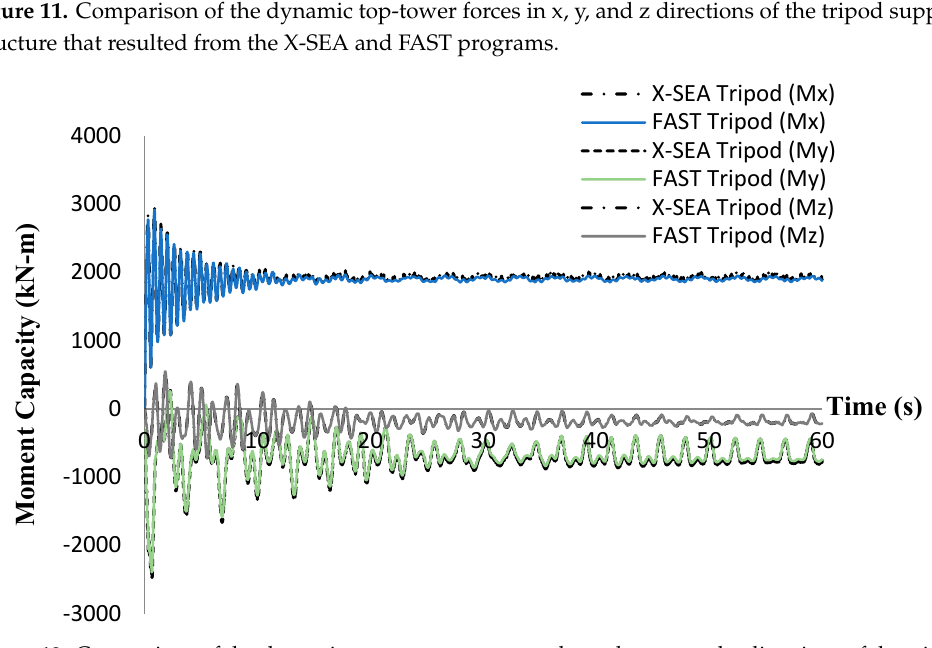
Figure 12. Comparison of the dynamic top-tower moments about the x, y, and z directions of the tripod support structure between the X-SEA and FAST programs.